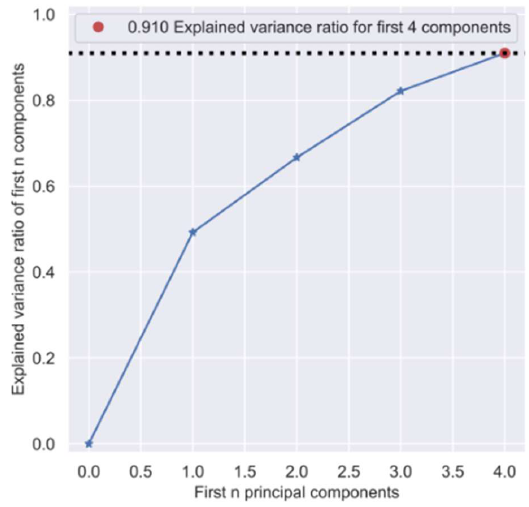
Figure 8. The cumulative contribution rate of